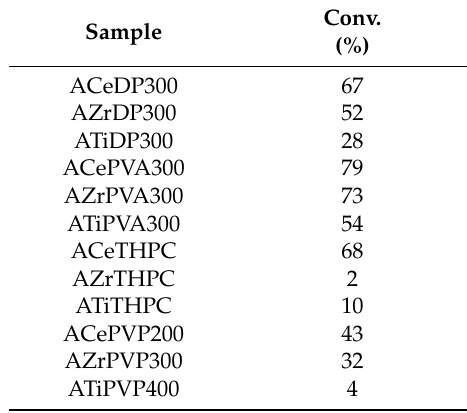
Table 2. Comparison of conversions after 60 min of reaction for D ‐ glucose oxidation at 60 °C and 100 cc/min of O 2 .